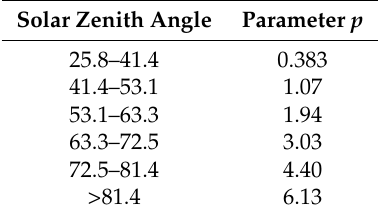
Table 1. Cloud reduction parameter p as a function of solar zenith angle [38].